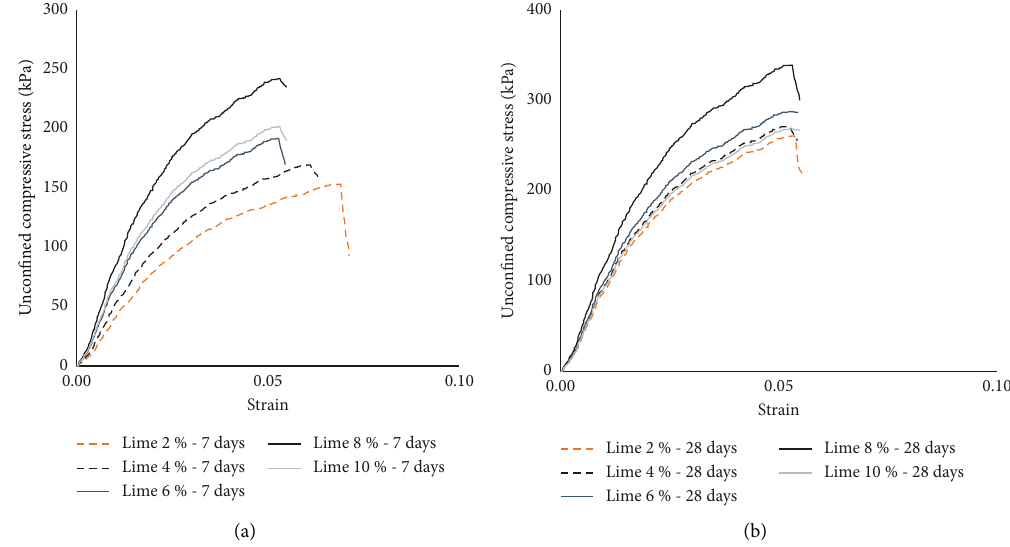
Figure 9: Results of the uniaxial soil compaction test for 28 days and different percentages of lime. (a) 7-day curing and (b) 28-day